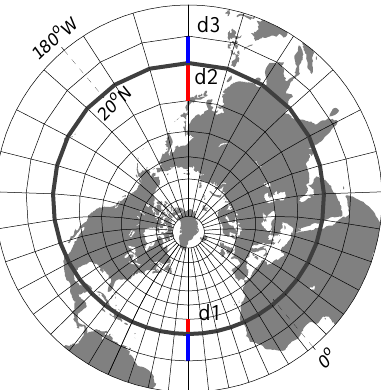
Figure 2. Northern patch constructed from a Moebius transforma- tion.